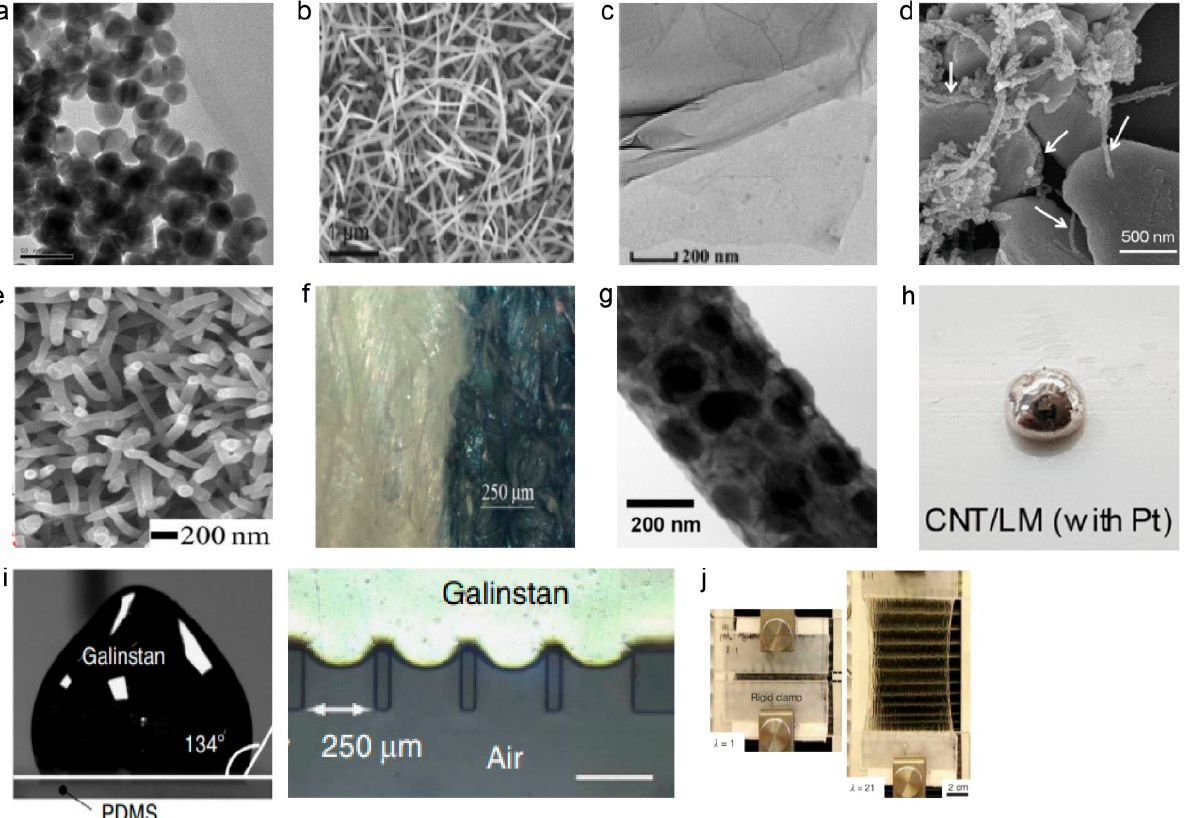
Figure 2. ( a ) Transmission electron microscopy (TEM) image of Ag NPs. Scale bar, 50 nm (reprinted with permission from